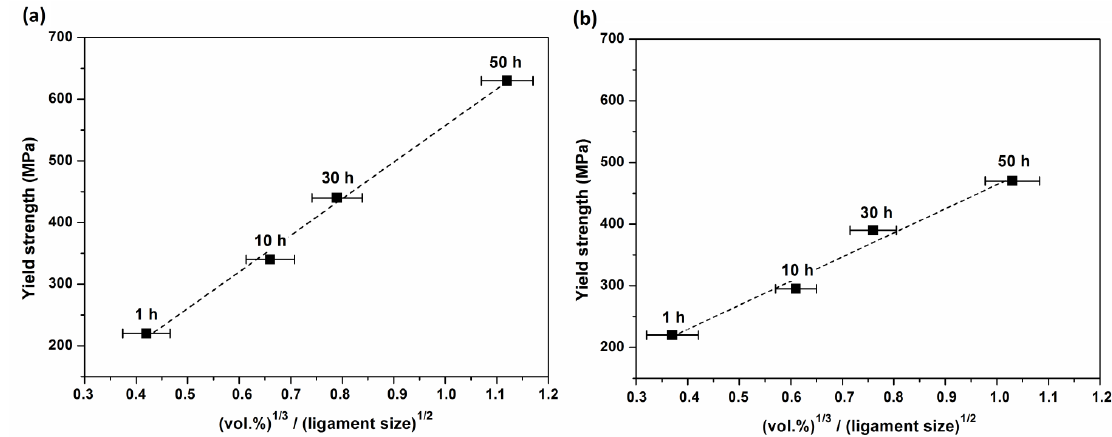
Figure 10. Yield strength as a function of volume fraction and matrix ligament size (σ ∞ V 1/3 λ −1/2 ) for consolidated samples: ( a ) milled and hot pressed and ( b ) milled, hot pressed and hot extruded